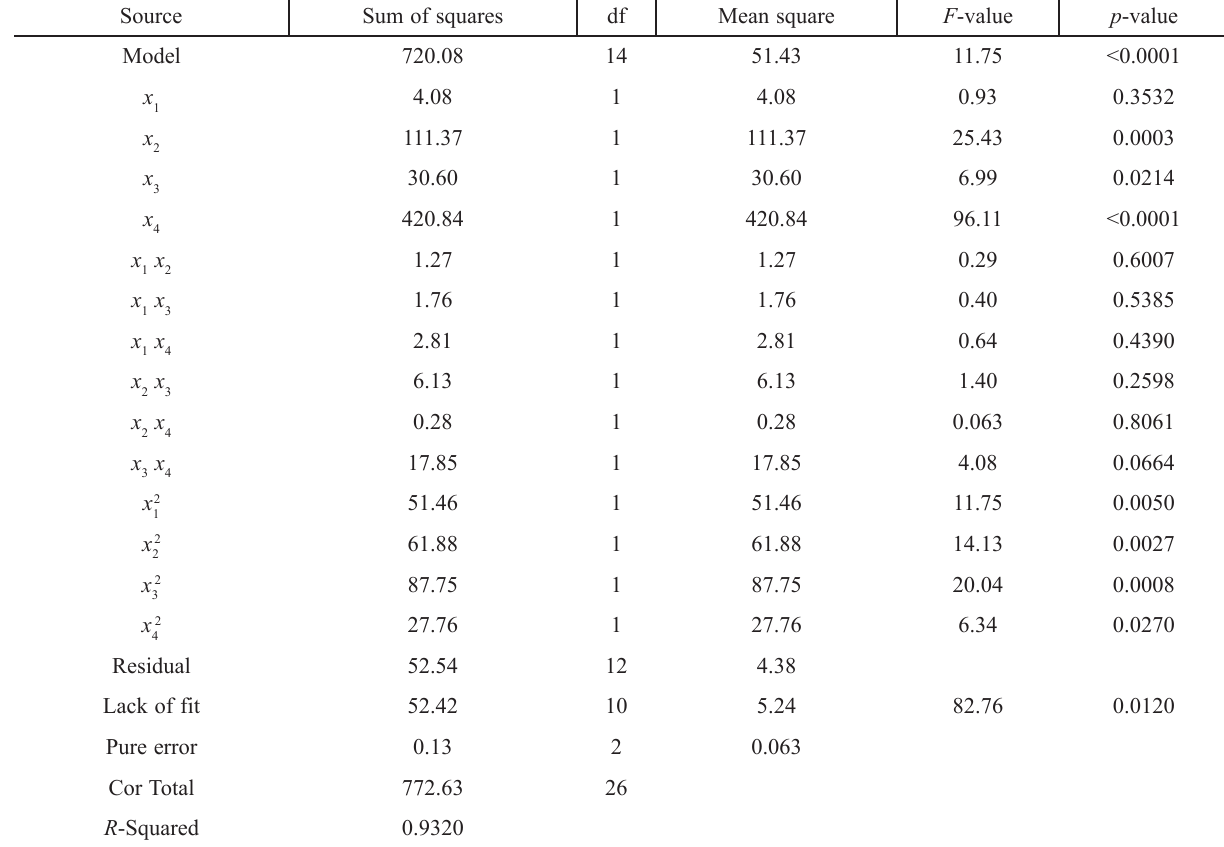
Table 4 – ANOVA for response surface quadratic model Source Sum of squares Mean